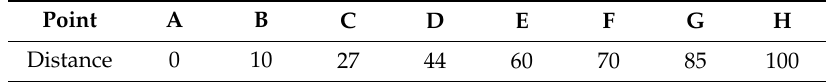
Table 1. The distance of the sampling points from A in the Yotsugi mill tailings pond (m). Point A B C D E F G H Distance 0 10 27 44 60 70 85